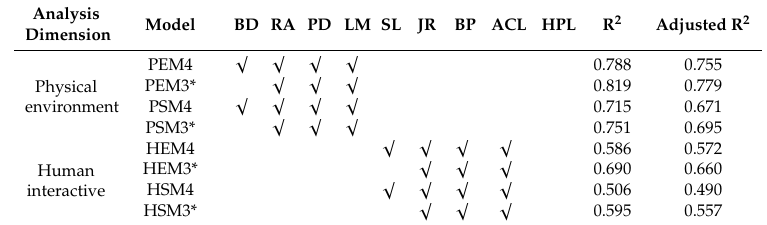
Table 5. Comparison of GWR model diagnostic indexes constructed by different indicators combinations.